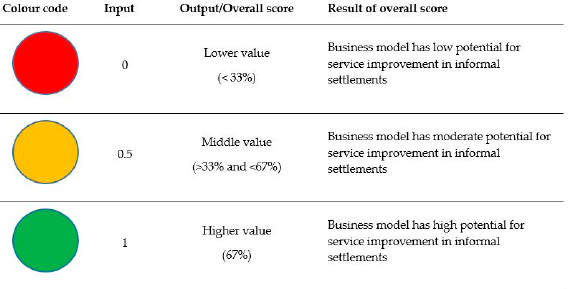
Figure 1. Color coding for input, output and overall score of the framework.